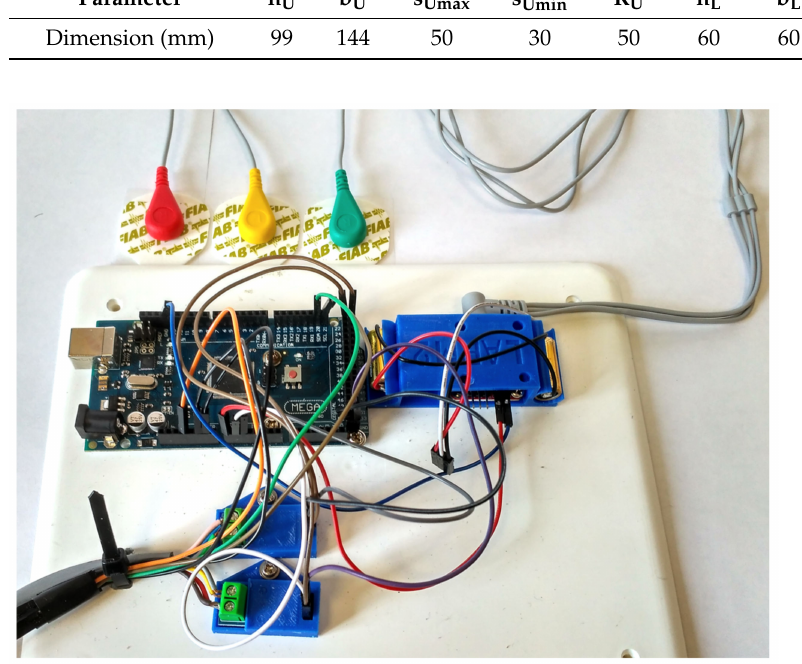
Figure 5. The data acquisition system of the prototype in Figure